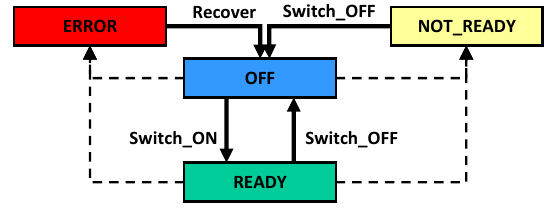
Figure 2. Finite State Machine